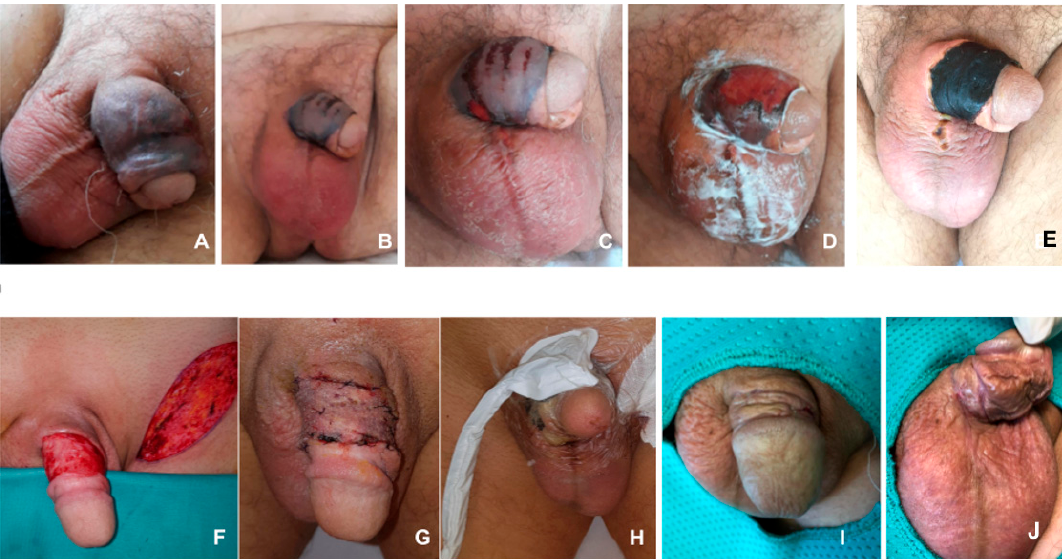
Figure 3. Clinical presentation of P. aeruginosa Fournier’s gangrene. ( A – D ) Evolving infection of penis and scrotum; ( E ) Development of a dry necrotic dorsal eschar; ( F ) Debridement of necrotic tissue of the penis shaft and full thickness skin taken from left inguinal area; ( G ) Full thickness skin grafted on the soft tissue loss; ( H ) Negative pressure dressing positioned over the skin graft to improve skin graft take ( I , J ).